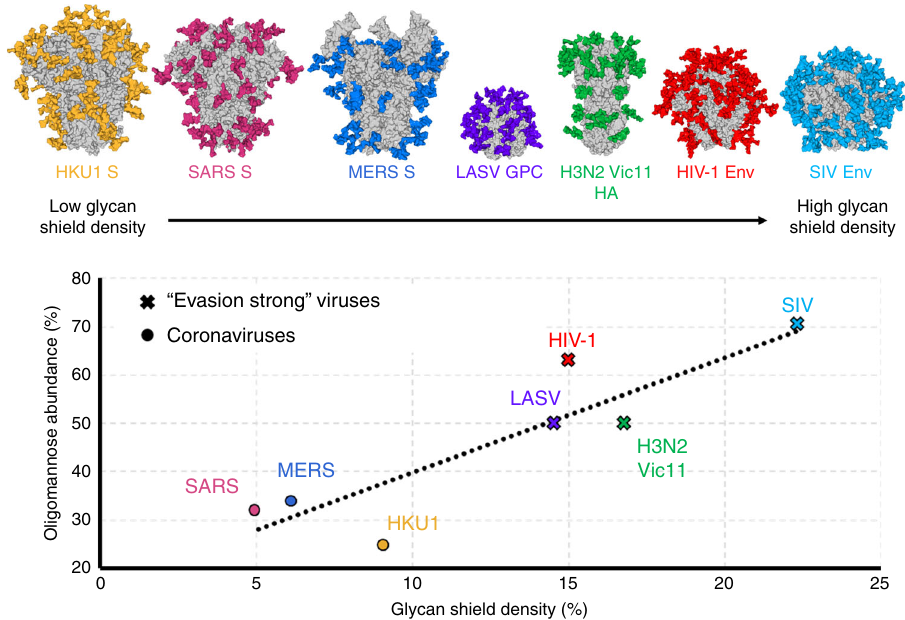
Fig. 6 Comparison of the glycan shields of viral class I fusion proteins. Glycan shield densities were calculated using Proteins, Interfaces, Structures and Assemblies (PISA) 83 analyses of fully glycosylated models of SARS S, MERS S, HKU1 S, LASV GPC, HIV-1 Env (BG505), In fl uenza H3N2 hemagglutinin (Victoria 2011), SIV Env (PDB ID 5X58, 5X59, 5I08, 5VK2, 4ZMJ, 4O5N, 6OHY, respectively) 9,11,53,84 – 86 . Oligomannose abundances of viral glycoproteins were ascertained by HILIC-UPLC analysis of PNGase F released N-linked glycans that were fl uorescently labelled with procainamide 24,45,53 (SI Fig. 5). The number of amino-acid residues interacting with N-linked glycans was divided by the number of solvent-accessible amino-acid residues of the glycoprotein as a measure for global glycan shield density. All viral glycoproteins analysed were expressed as trimers in HEK293F cells apart from LASV GPC, which was derived from virus-like particles from Madin-Darby canine kidney II